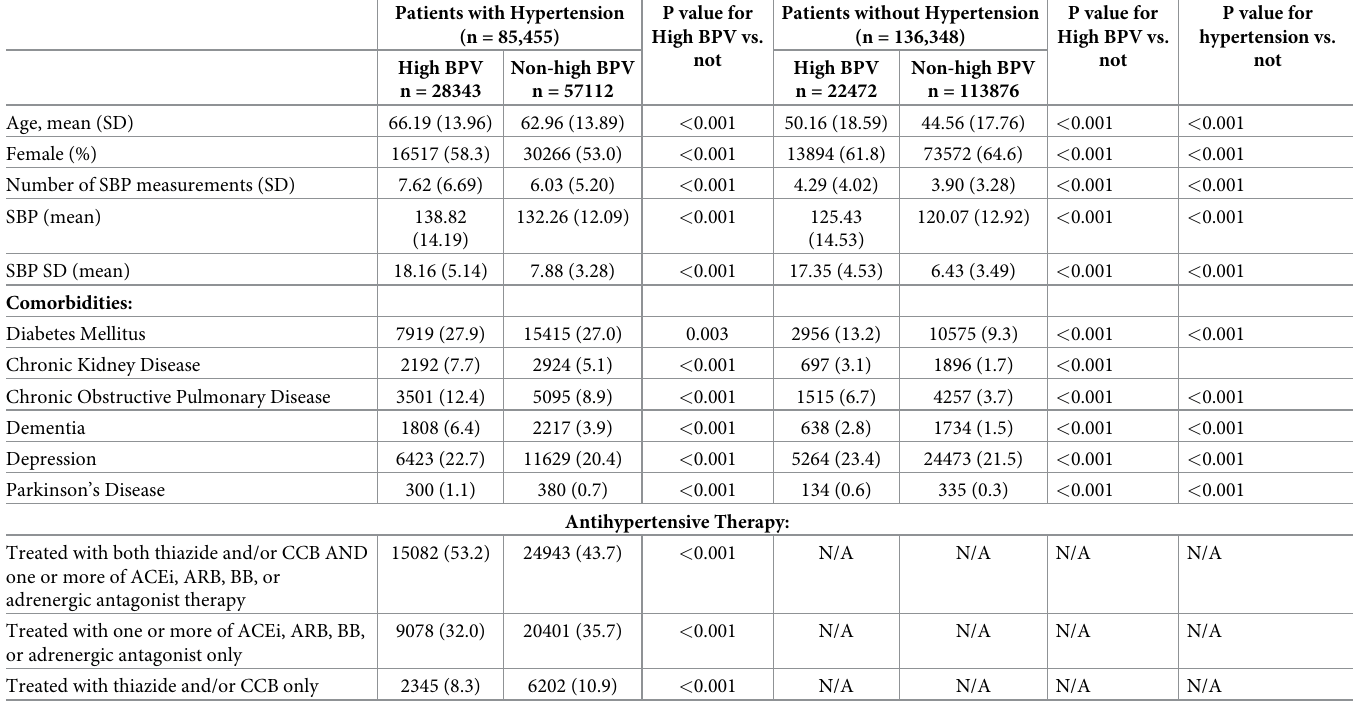
Table 1. Patient characteristics.